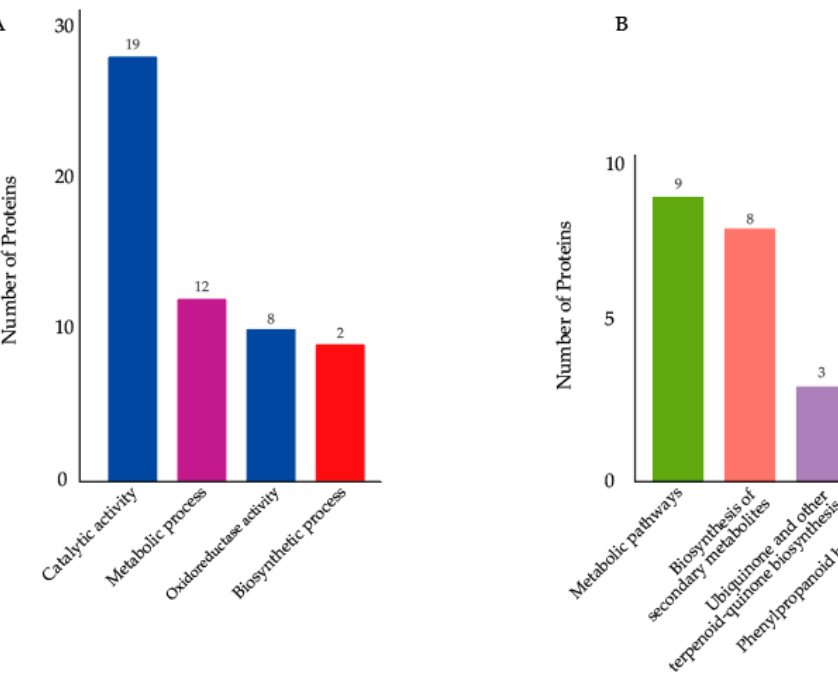
Figure 3. ( A ) Significantly enriched GO terms of differentially expressed proteins DEPs. ( B ) Significantly enriched KEGG pathways of DEPs.